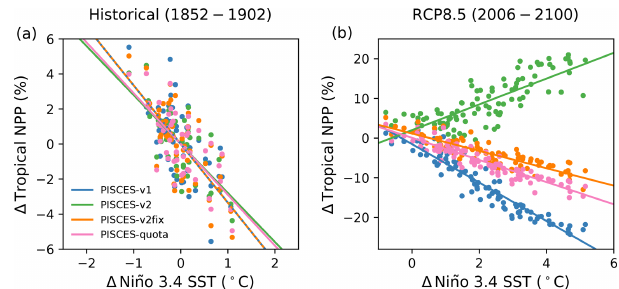
Figure 7. The relationship between annual anomalies in tropi- cal (30 ◦ N–30 ◦ S) NPP and Niño 3.4 region SST anomalies over (a) 1852–1902 for historical simulations and (b) 2006–2100 for RCP8.5 for PISCES-v1 (blue), PISCES-v2 (green), PISCES-v2fix (orange) and PISCES-quota